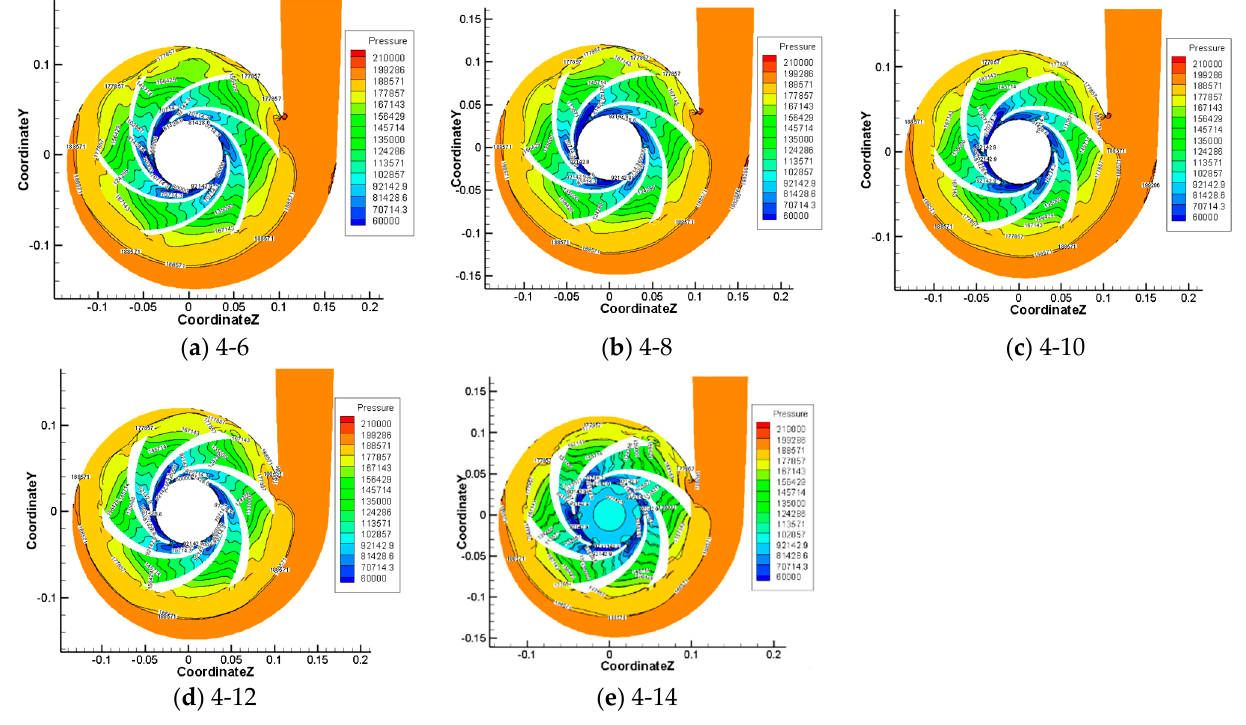
Figure 10. Pressure distribution of VTB.